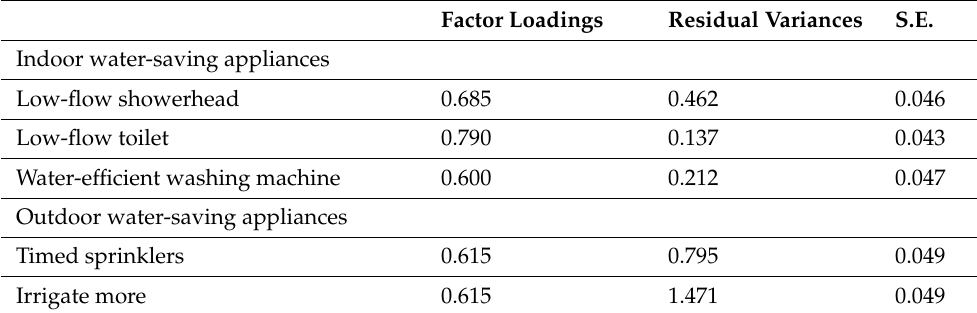
Table A1. Standardized model results of owning water-saving appliances for appliances for indoor and outdoor usage regressed on well ownership.